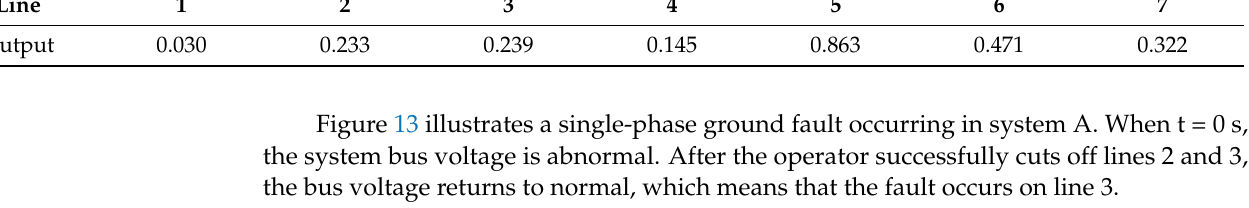
Figure 11. The effect of termination accuracy on the test accuracy of the model.